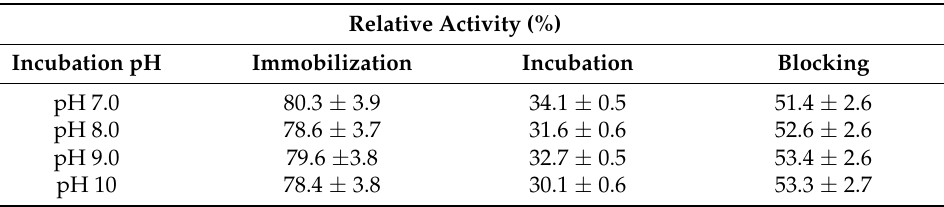
Table 3. Effect of the incubation pH in the relative hydrolytic activity of PGA. Immobilization was performed in 5 mM of sodium phosphate at pH 7.0. Incubation was carried out using 25 mM of sodium phosphate at pH 7.0 and 8.0 or sodium carbonate at pH 9.0 and 10.0 (an additional 100 mM of phenylacetic acid and 30% glycerol were always added) for 3 h. Blocking was performed using